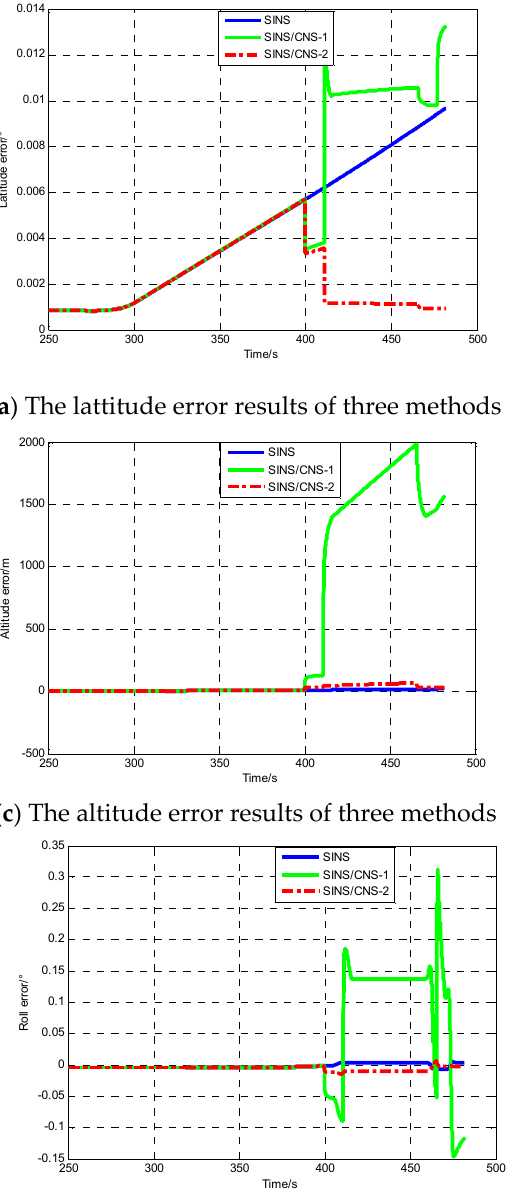
( e ) The roll error results of three methods ( f ) The heading error results of three methods Figure 4. Comparision of the navigation errors between strapdown inertial navigation system (SINS), SINS/CNS integration method without considering star sensor installation errors (SINS/CNS-1), SINS/CNS integration method considering star sensor installation errors (SINS/CNS-2).